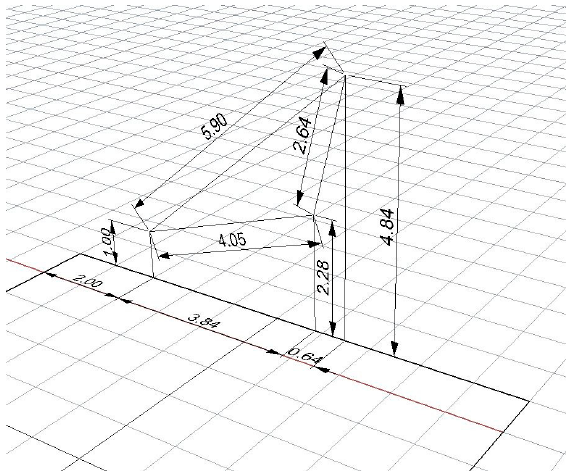
Figure 17. Sketch of the dimensions of a vertical scalene triangle radiating over a horizontal area of 10 × 10 m 2 .